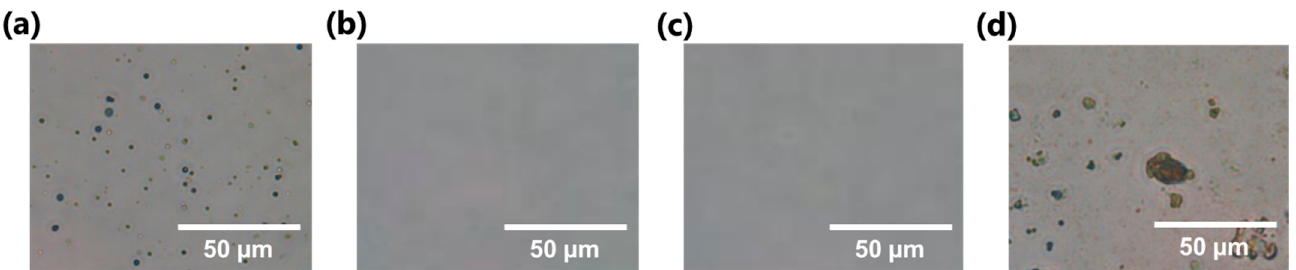
Figure 3. Optical images of DHP microparticles (MPs) synthesized ( a ) in the presence of 0.8% ( w/v ) TOCNF with HRP and H 2 O 2 , ( b ) w/o HRP, and ( c ) w/o H 2 O 2 using the Zulaufverfahren (ZL) method. ( d ) Zutropfverfahren (ZT) method using 0.8% ( w/v ) TOCNF with HRP and H 2 O 2 .